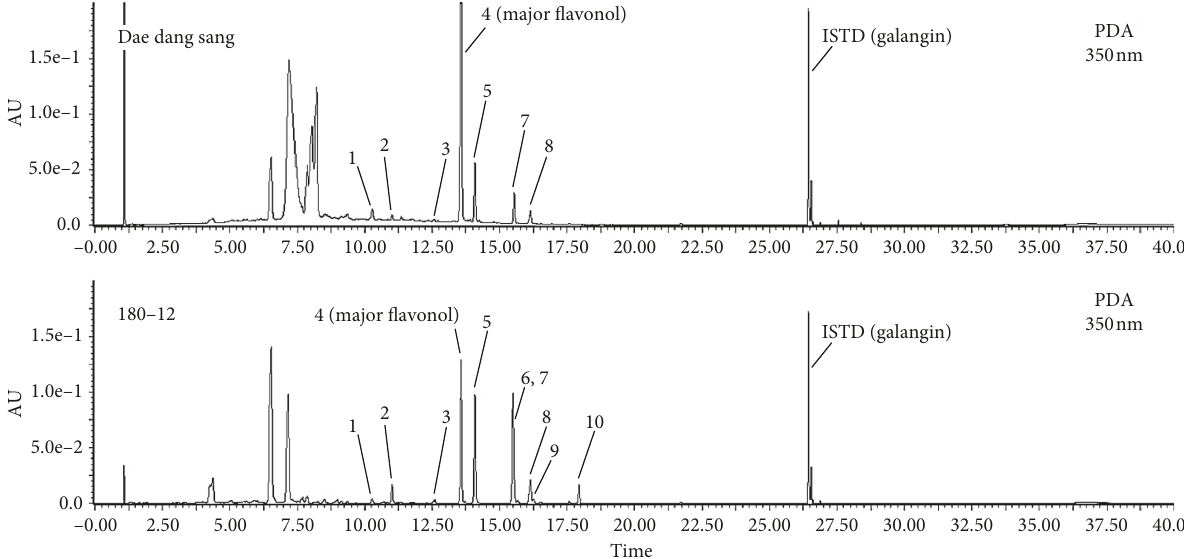
Figure 1: LC chromatograms of flavonoids in samples of Korean mulberry fruits ( Morus alba L.).